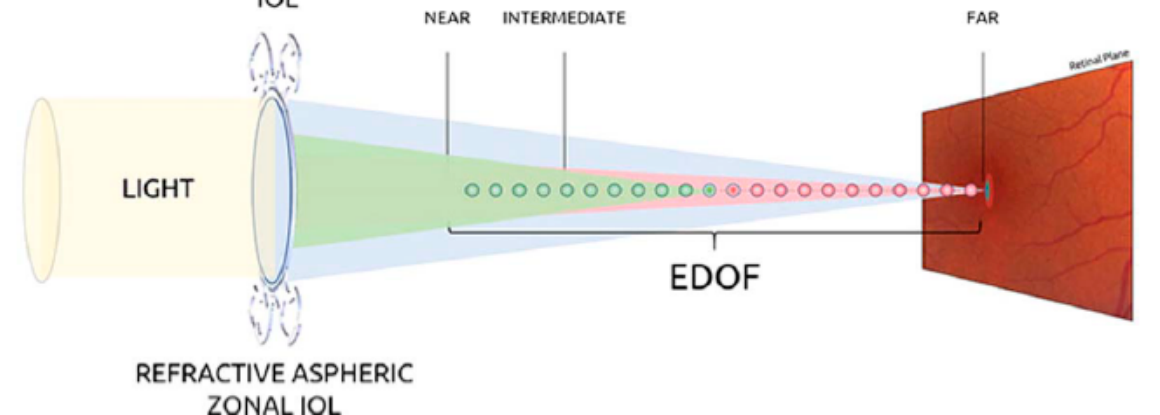
Figure 2. Basic principle of Mini Well and Mini Well Proxa EDOF-IOLs. Reprinted with permission from Ref. [15]. Copyright © 2023, Wolters Kluwer Health.